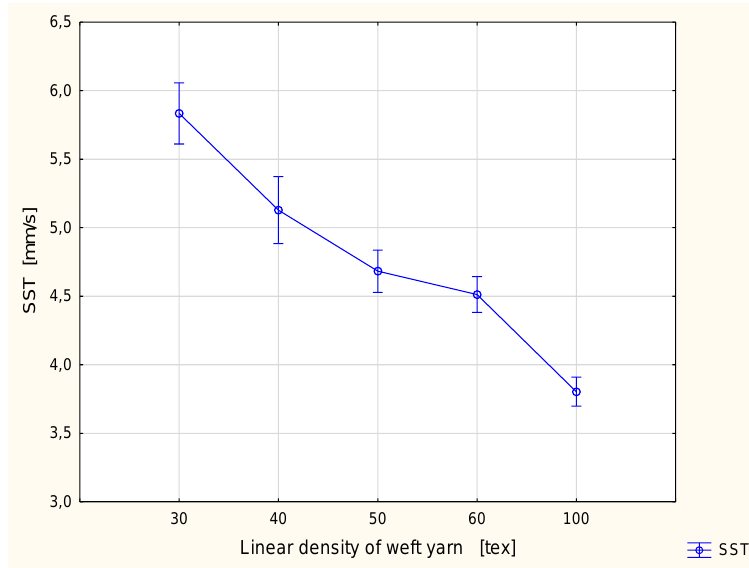
Figure 6. Spreading speed for the top fabric surface vs. linear density of the weft yarn.